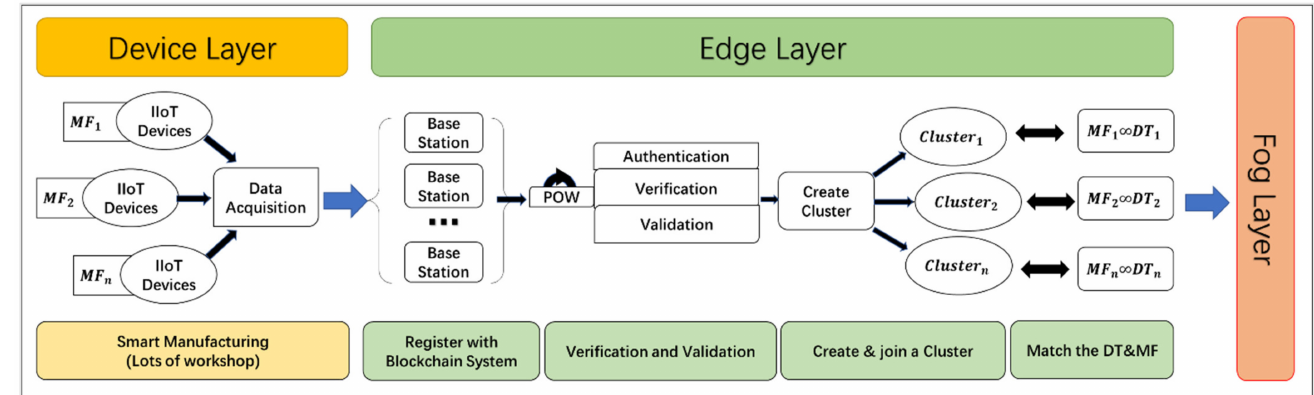
Figure 2. Flowchart of the proposed framework in device and edge